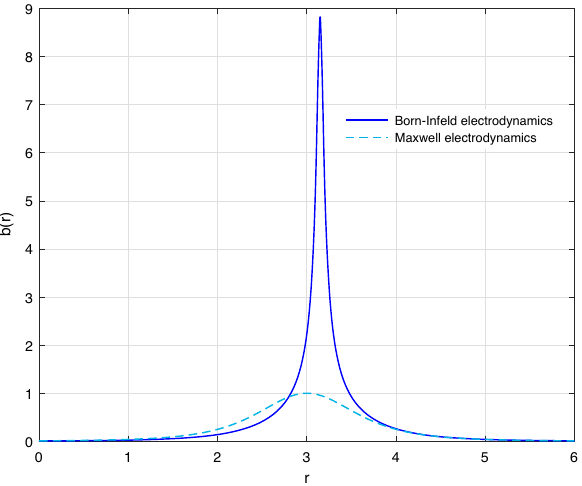
Fig. 1 Normalized magnetic field induction as a function of the radial coordinate r